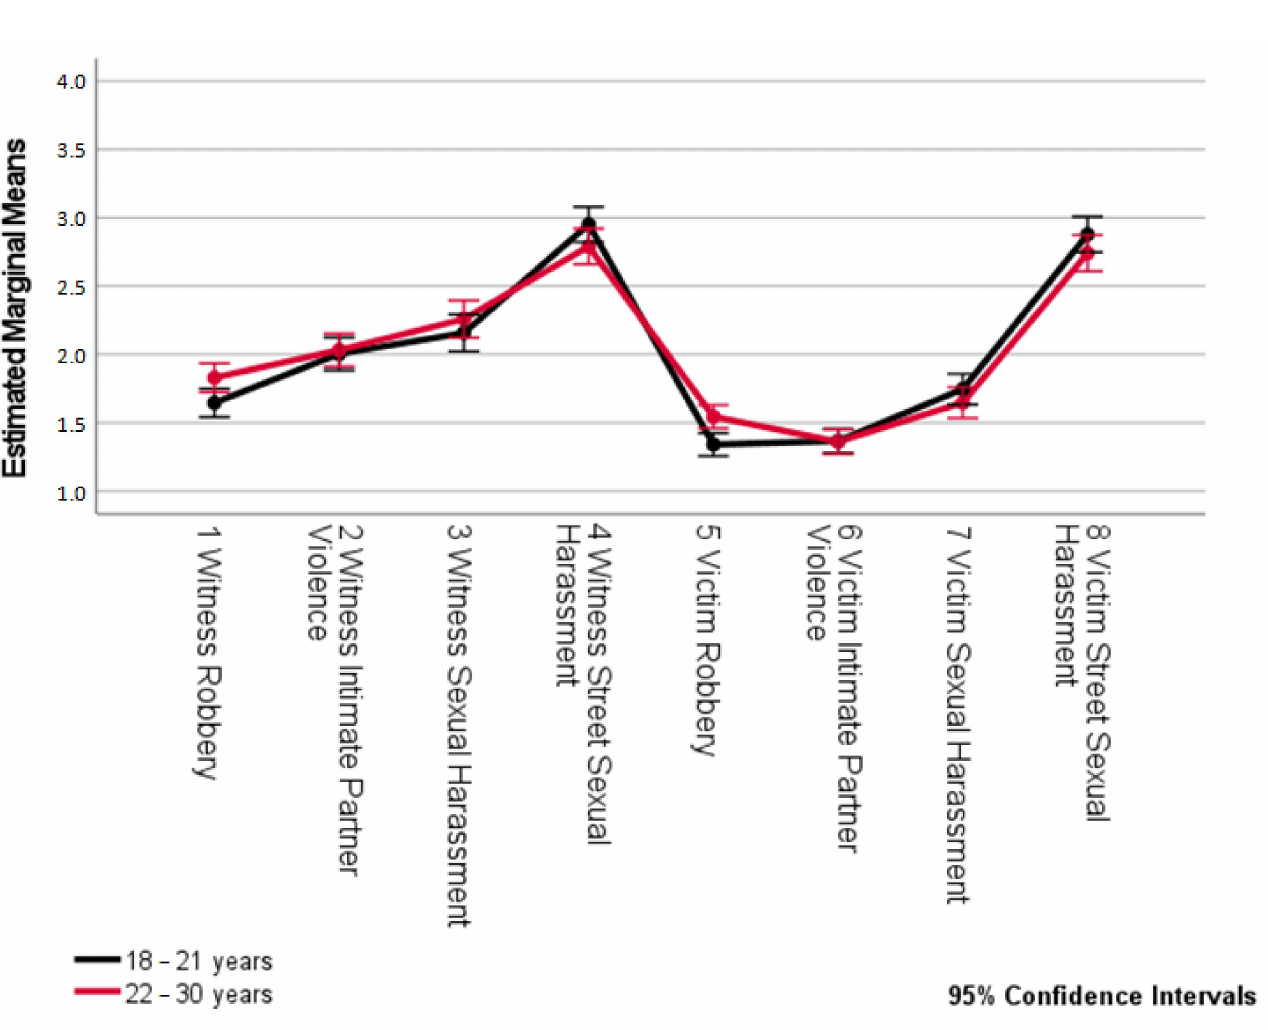
Figure 4. Differences in victimization types by